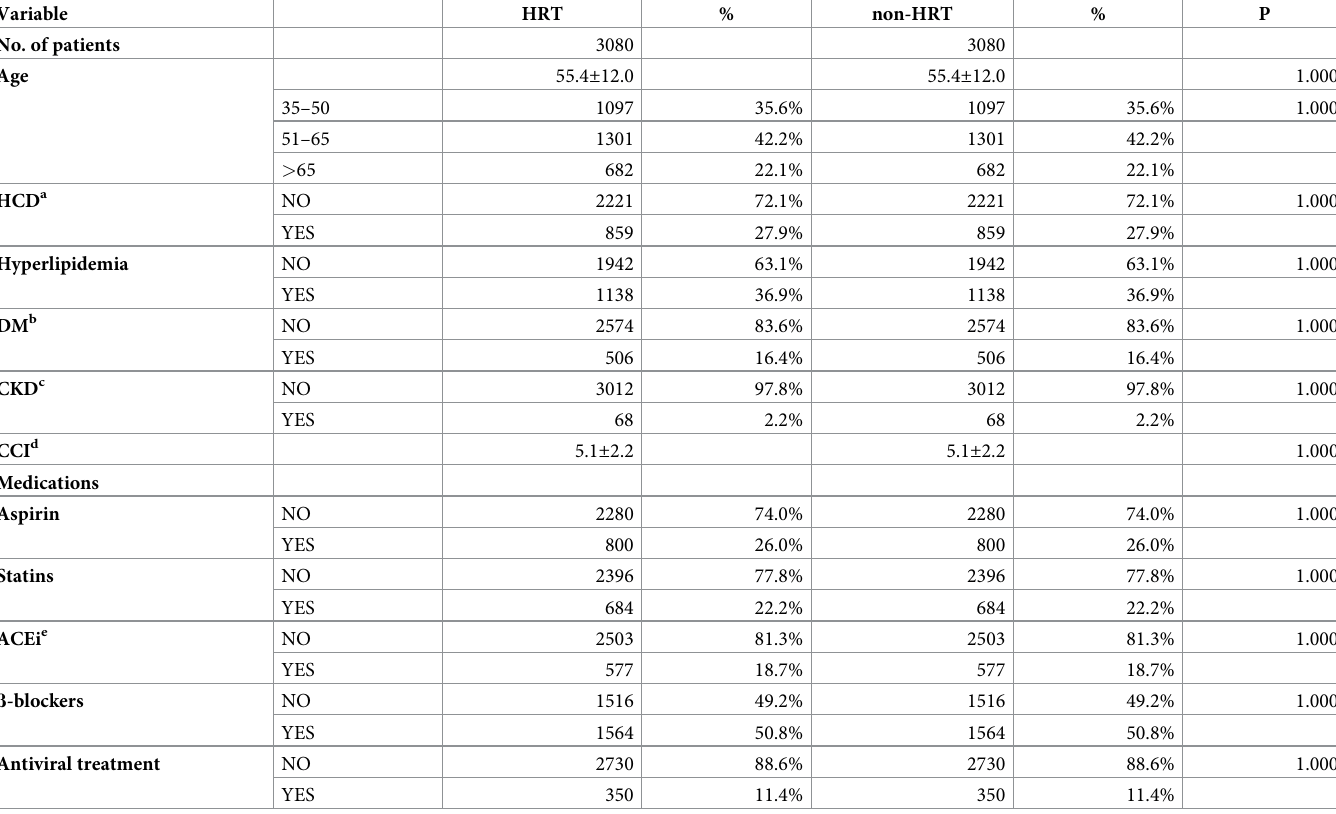
Table 1. Characteristics of patients in the Hormone Replacement Therapy (HRT) Cohort and the non-HRT cohort after matching. Variable